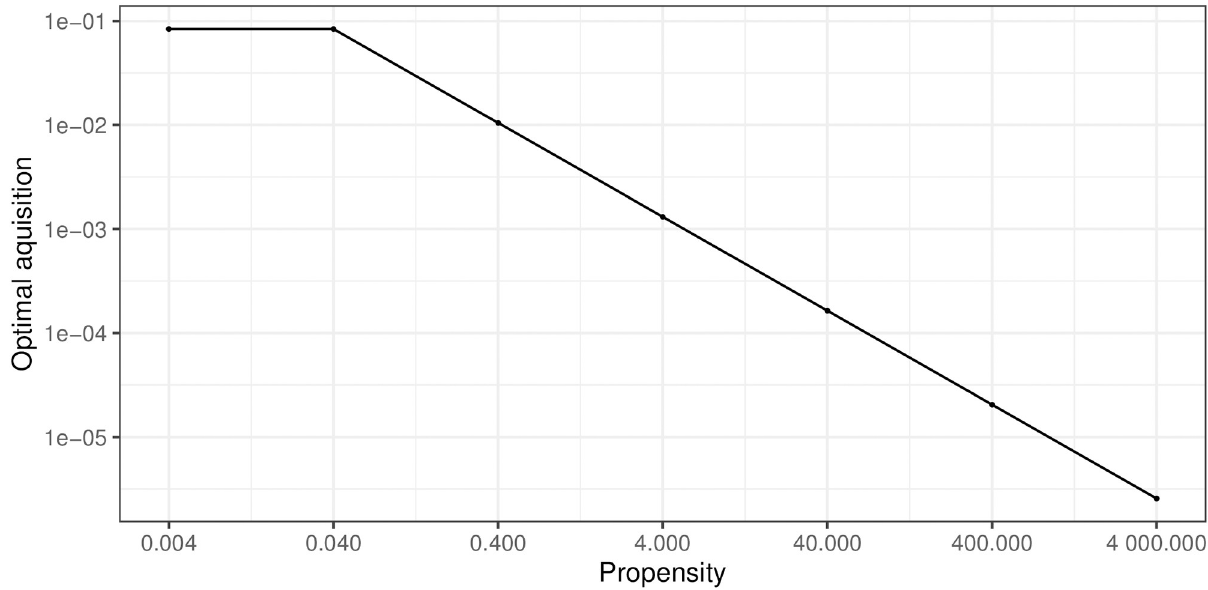
Fig 5. High levels of propensity selects for lower optimal probability of spacer acquisition. A control strain with a probability of acquisition at 10 − 5 competes with a strain of interest, with various acquisition probabilities. Both strains defend using a type I/II CRISPR-Cas system ( μ = 3.4 � 10 − 7 ). For each propensity (0.004, 0.04, 0.4, 4, 40, 400 and 4000), we took the median fitness of the bacteria and reported as the optimal probability of spacer acquisition, the probability associated with the highest